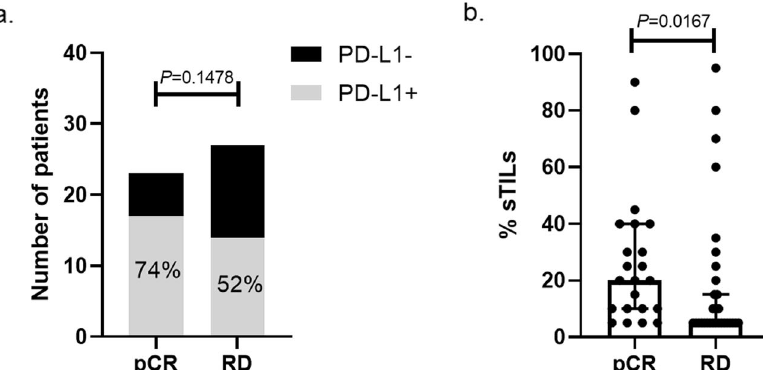
Fig. 1 PD-L1 positivity and stromal TILs (sTILs) by pathologic response category. a PD-L1-positivity rate by SP263 antibody in the pathologic complete response (pCR, 74%, n = 14), and residual disease (RD, 52%, n = 13) groups, respectively, p = 0.148 (two-sided Fisher ’ s exact test). b The percentage of manual stromal tumor-in fi ltrating lymphocytes (sTILs) and the median (horizontal line) in the pCR (median: 20%) and RD groups (median: 5%), error bars represent 95% con fi dence intervals, p = 0.0167 (Mann – Whitney U test).